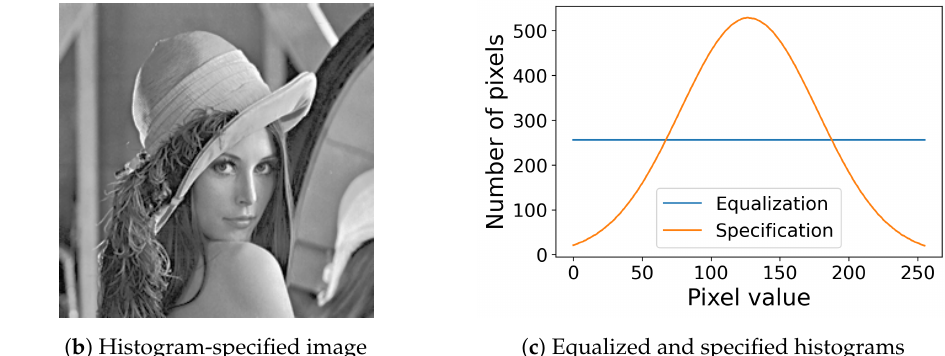
Figure 5. Exact histogram equalization and specification: ( a ) histogram-equalized image of the original image in Figure 1a; ( b ) the histogram-specified image with a Gaussian target histogram; ( c ) equalized (blue line) and specified (orange line)